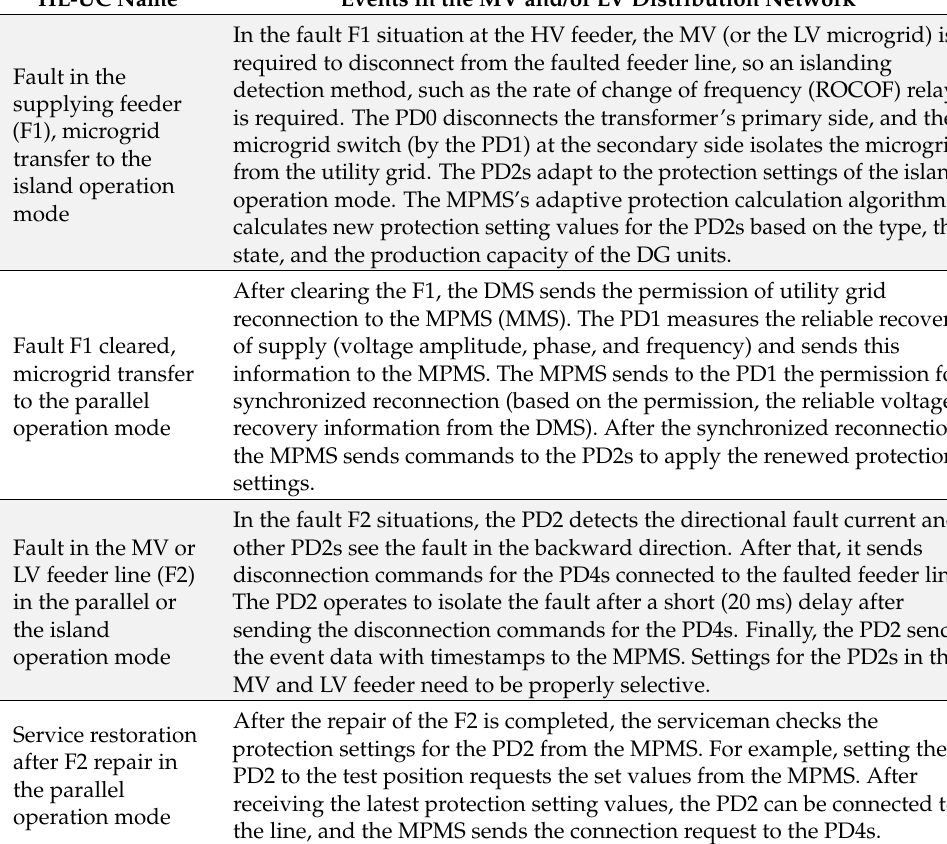
Table 7. Protection management high-level use cases in the microgrid